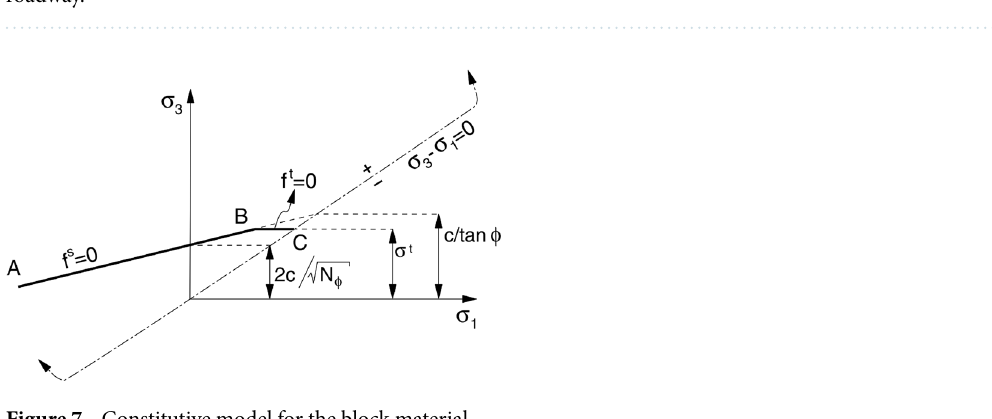
Figure 6. Monitoring instruments for the roadway surrounding behaviours in the mining face and formed roadway.